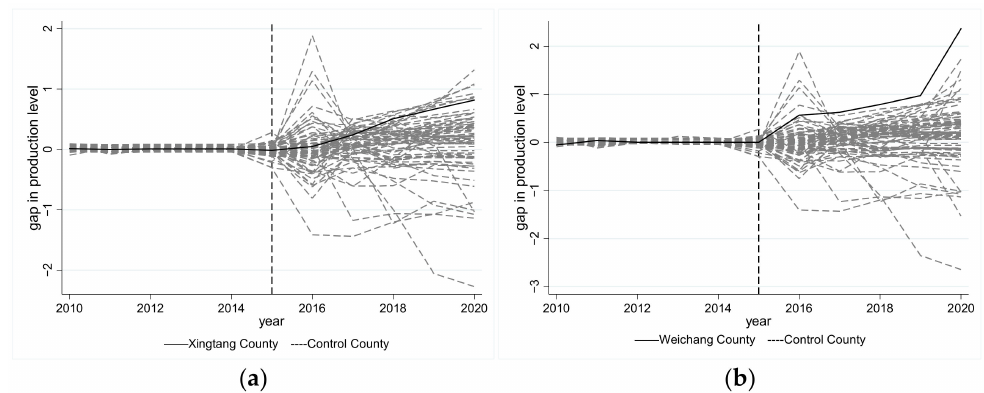
Figure 7. Herbivorous livestock production level gaps in all sample points, ( a ) when Xingtang County is the treatment group, ( b ) when Weichang County is the treatment group.